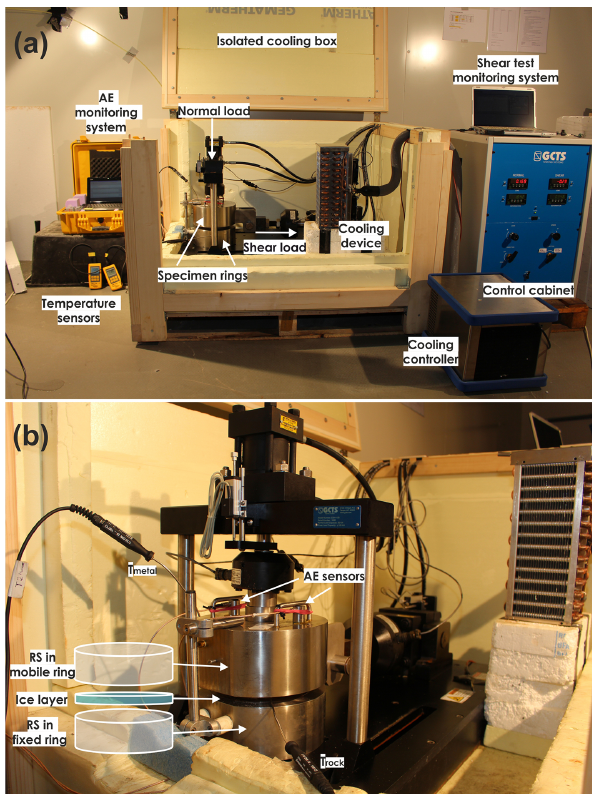
Figure 3. Experimental set-up showing the laboratory shear ma- chine, acoustic emission monitoring system, the cooling device and the cooling box. RS: rock sample. T : rock temperature